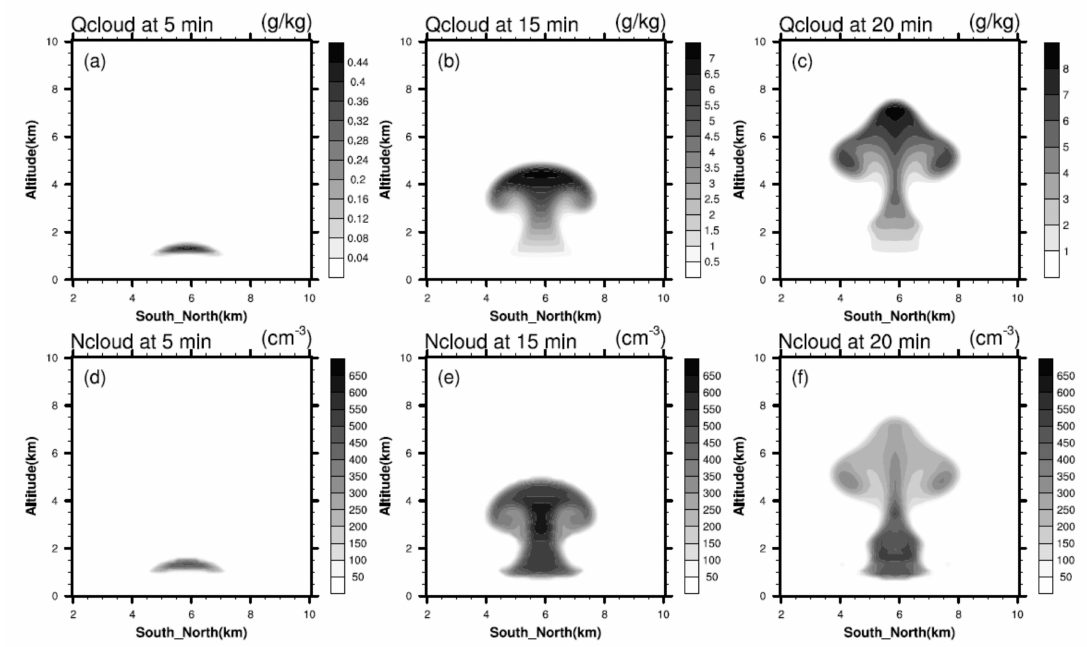
Figure 2. Cloud water mixing ratio and number concentration in the 3D radiation case at 5 min ( a , d ), 15 min ( b , e ), 20 min ( c , f